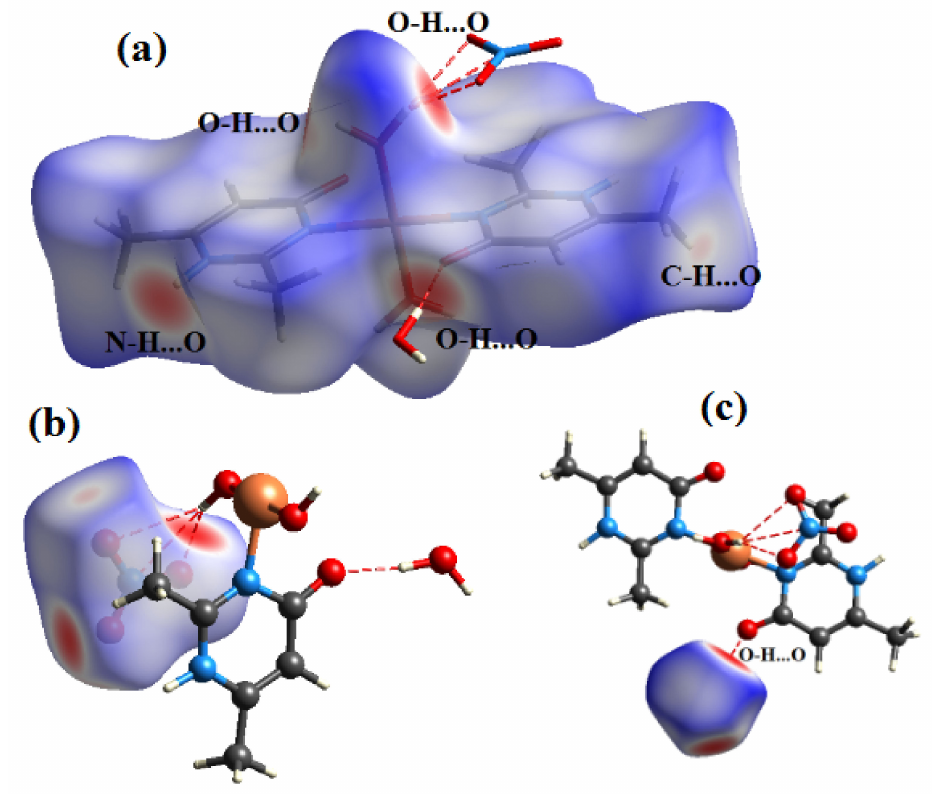
Figure 7. View of the d norm mapped on the Hirshfeld surface of compound ( 1 ) (the red spots represents intermolecular contacts between atoms). ( a ) around the complex ion, ( b ) around the nitrate anion and ( c ) around the water